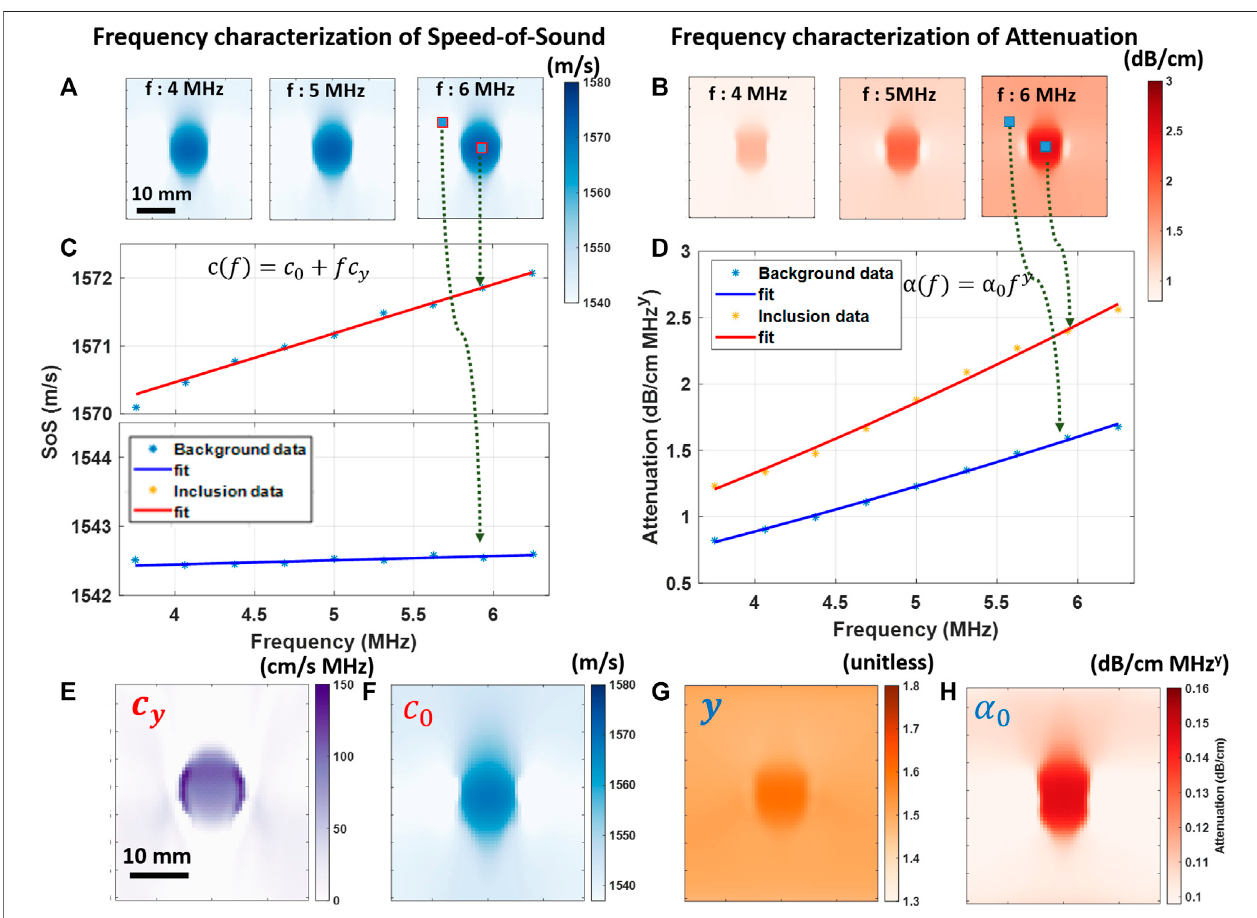
FIGURE 3 | Illustration of parameter estimation for SoS and UA on a sample simulated numerical phantom: SoS (A) and UA (B) reconstructions at frequencies f = {4, 5, 6}MHz obtained by following the procedure in Figure 2 . Fitting frequency-dependent models as in Eqs.8 for SoS (C) UA (D) at two sample locations inside and outside the inclusion. By solving the inverse problem in Eq.9, spatial distributions of the following model parameters are obtained: SoS coef fi cient i . e ., c y (E) , SoS dispersion coef fi cient